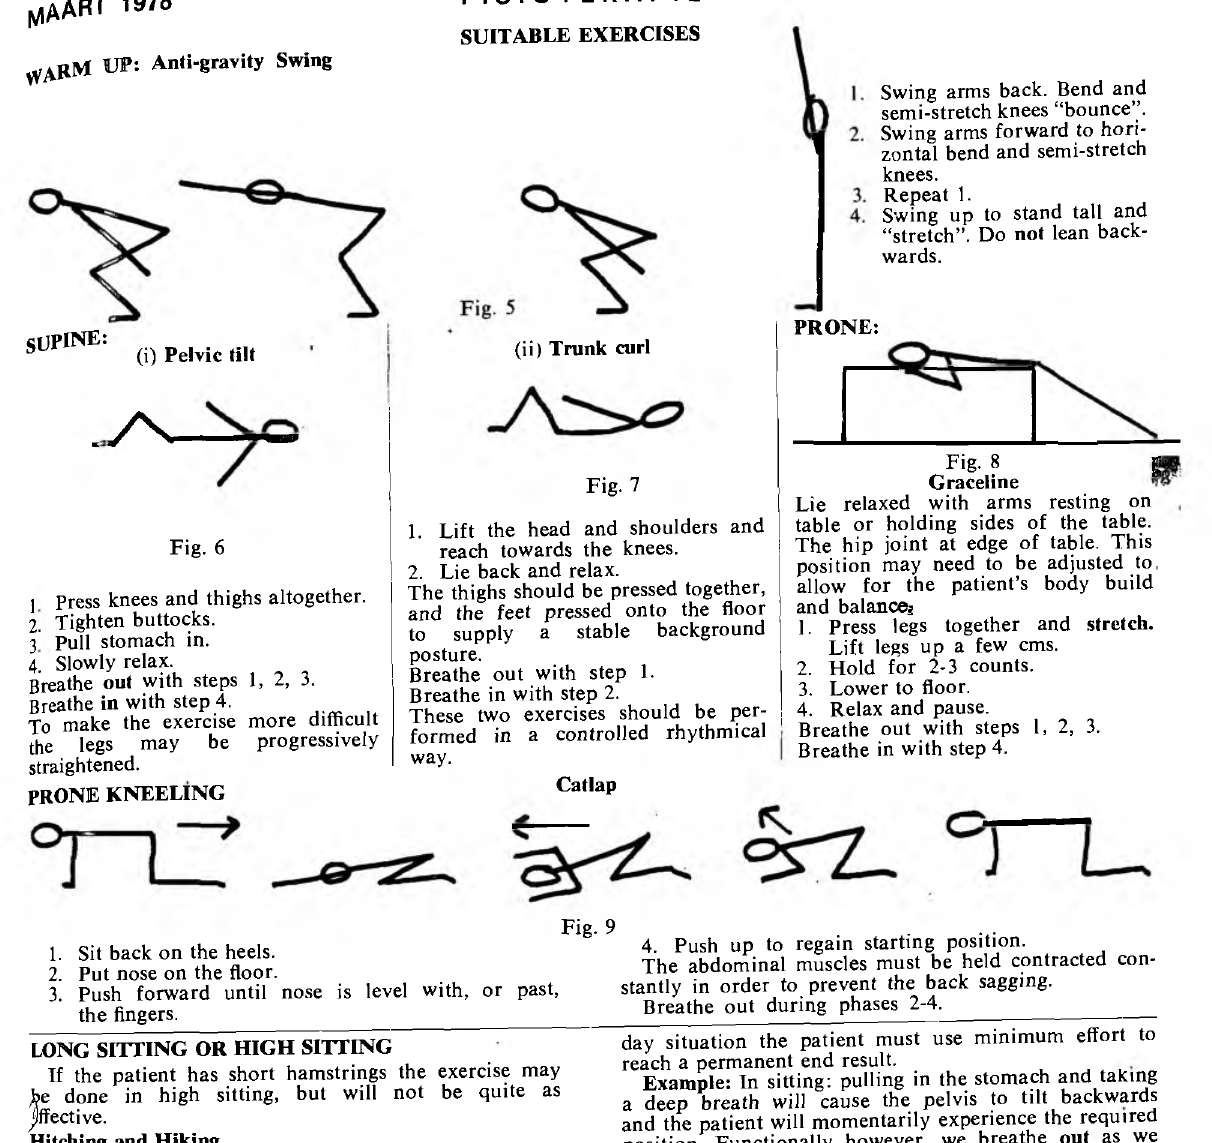
Fig. 9 4. Push up to regain starting position. The abdominal muscles must be held contracted con­ stantly in order to prevent the back sagging. Breathe out during phases 2-4.